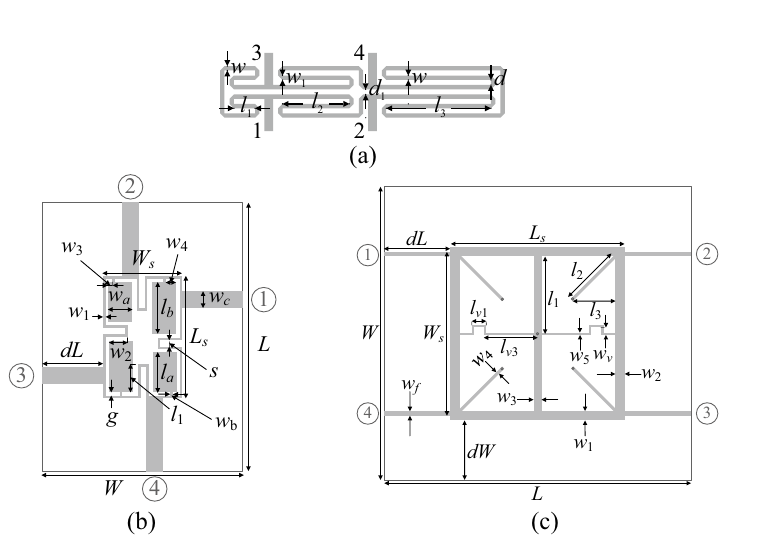
Figure 5. Verification circuits used for validation of the yield optimization framework of “Yield optimization of microwave passives using multi-fidelity response features” section: ( a ) miniaturized rat-race coupler with folded transmission lines (Coupler I) 43 , ( b ) compact branch-line coupler (Coupler II) 44 , ( c ) dual-band branch-line coupler (Coupler III) 45